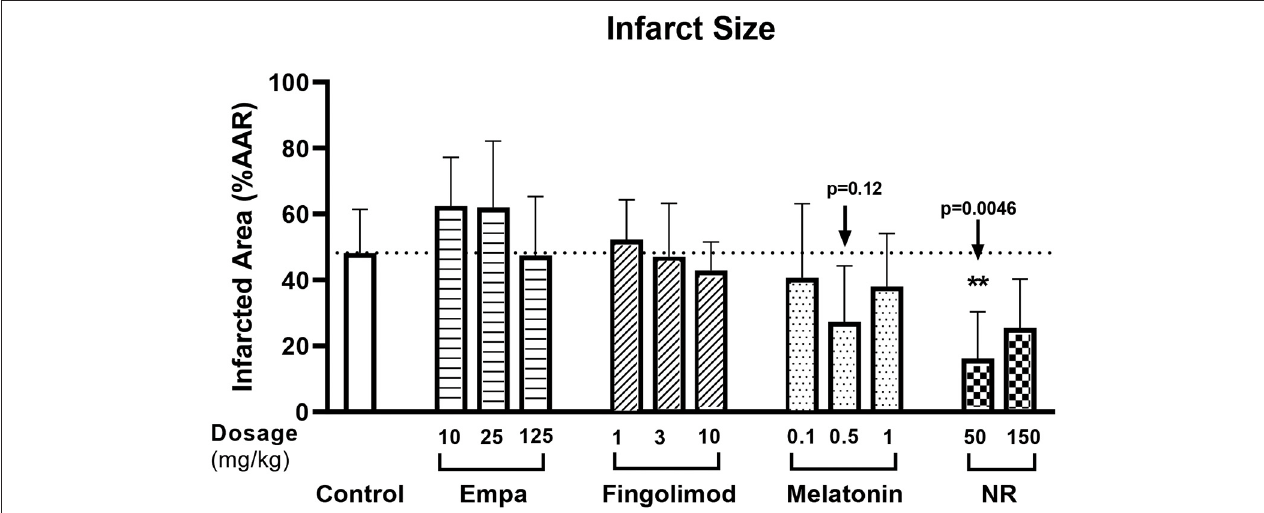
FIGURE 2 | Pilot dose-response of potential cardioprotective agents. The experiment followed protocol 1, rats were randomly subjected to empagliflozin [Empa;10 ( n = 4), 25 ( n = 4), 125 ( n = 5) mg/kg], fingolimod [1 ( n = 4), 3 ( n = 4), 10 ( n = 4) mg/kg], melatonin [100 ( n = 4), 500 ( n = 6), 1,000 ( n = 4) µ g/kg], or nicotinamide